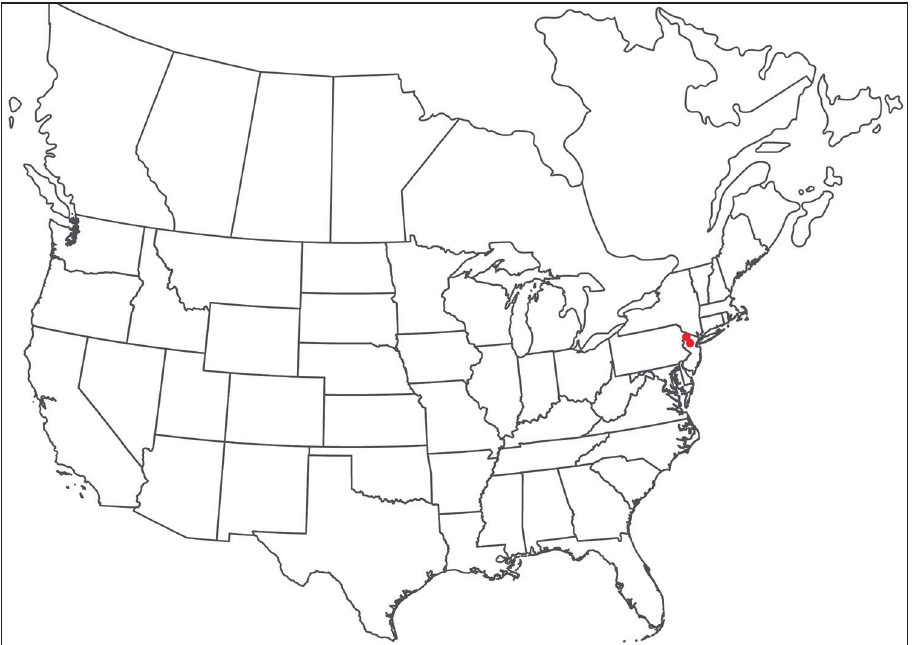
Figure 228. Torrenticola rufoalba